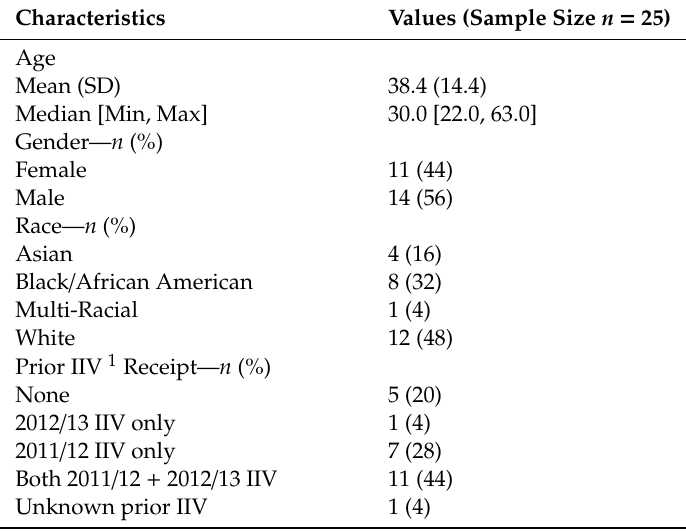
Table 1. Demographic and baseline characteristics of